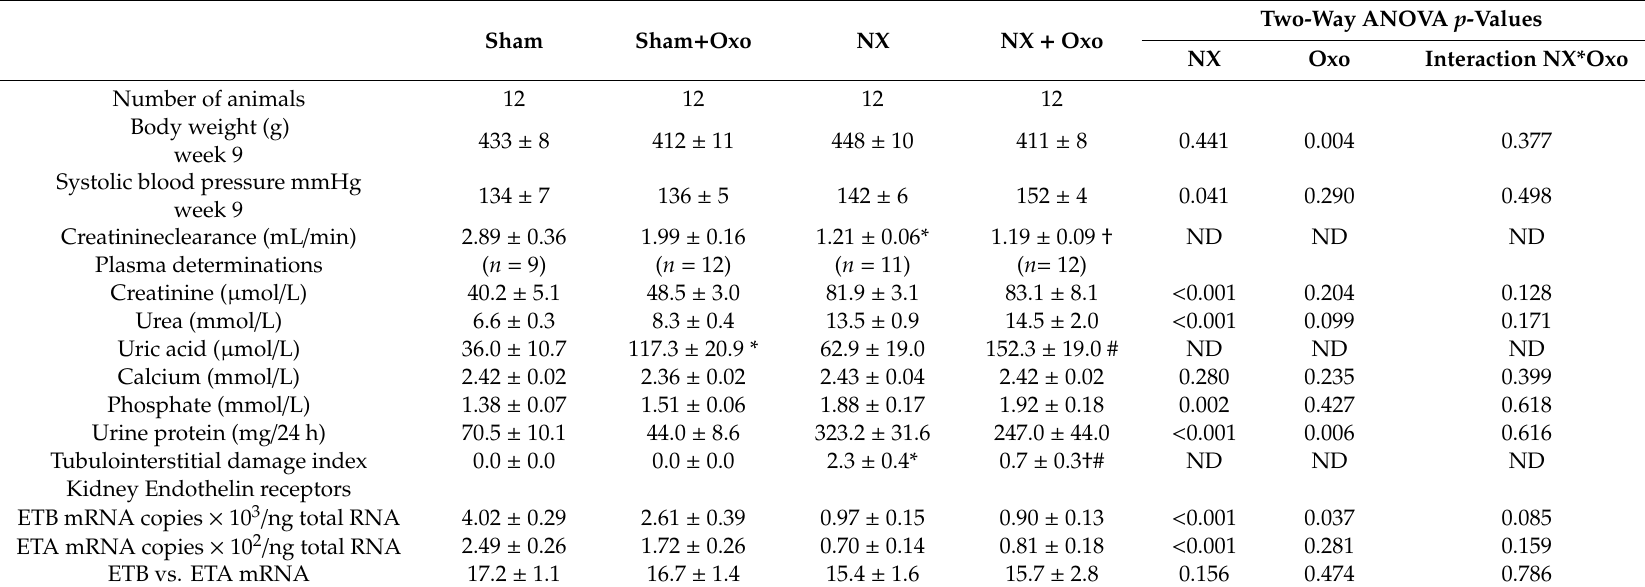
Table 1. Animal data and laboratory findings at the end of the twelve-week 5 / 6 nephrectomy model. Sham Sham + Oxo NX NX + Oxo